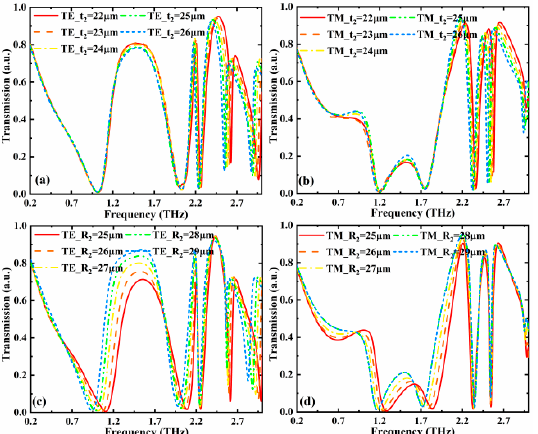
Figure 8. Transmission versus operation frequency with different t 2 for ( a ) TE- and ( b ) TM-polarized incident terahertz wave and different R 2 for ( c ) TE- and ( d ) TM-polarized incident terahertz wave when the conductivity of VO 2 and chemical potential of graphene are σ VO eV and the polarization angle of incident wave is 45°.